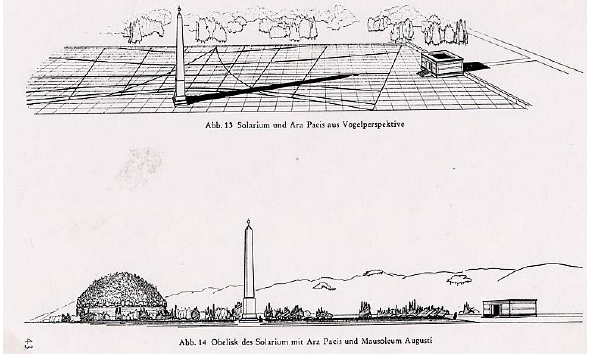
Figure 13: Part of the meridian (looking south) below a cellar in